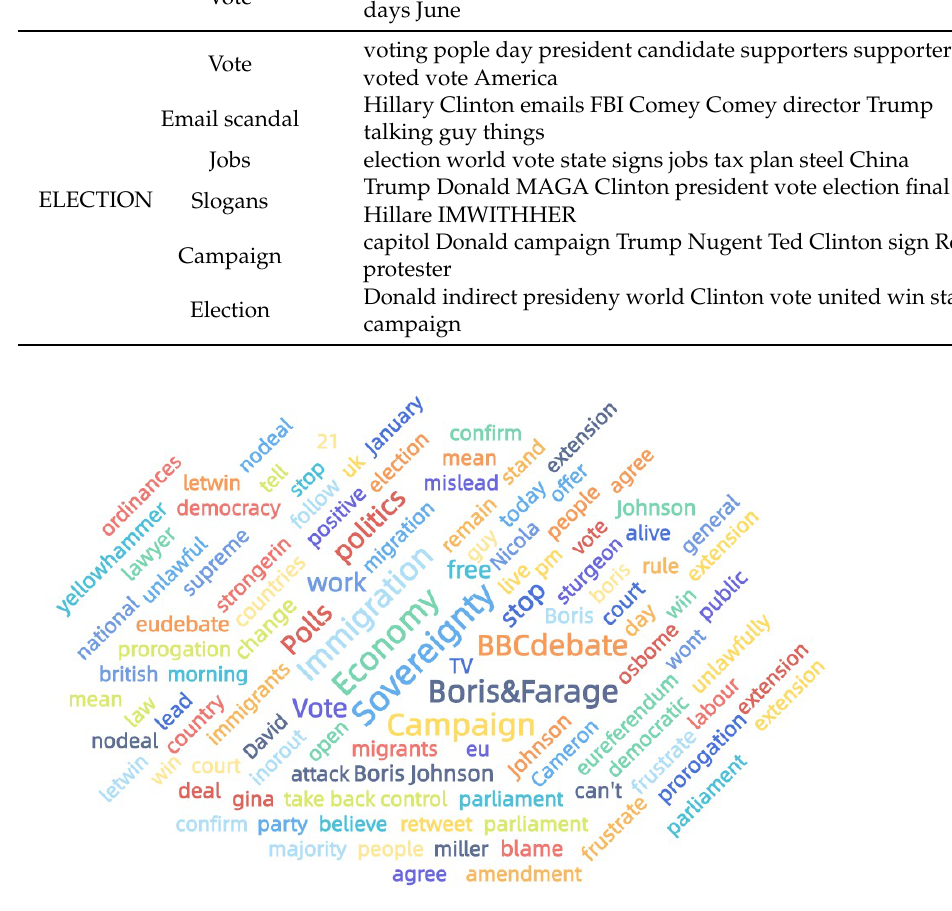
Figure 5. Topic word cloud of BREXIT